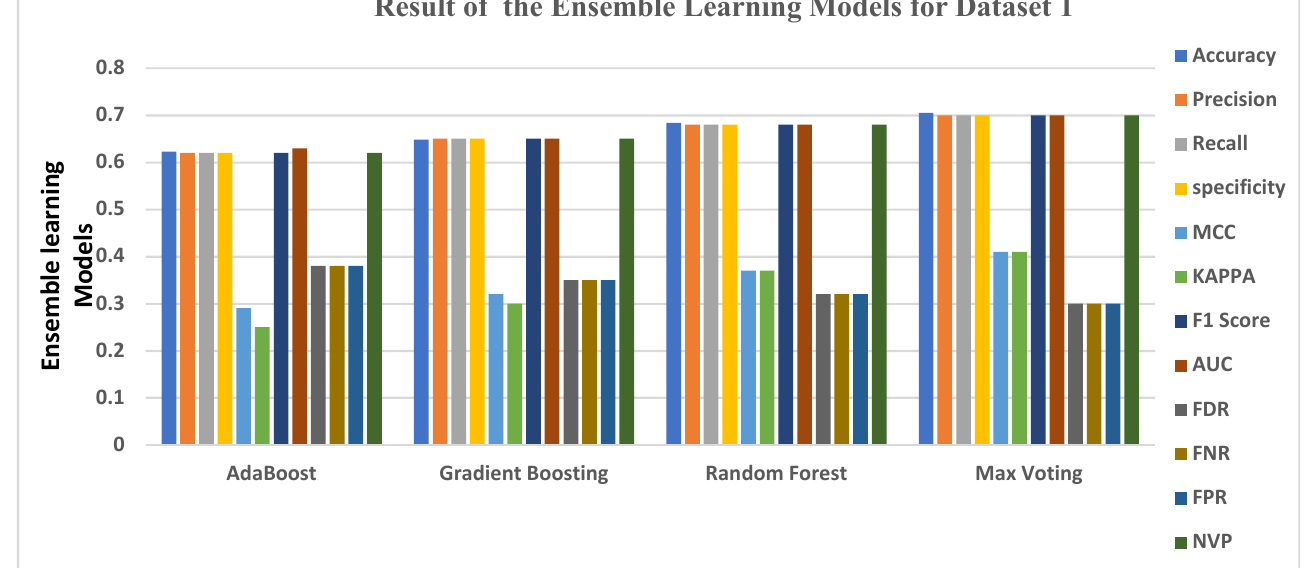
Figure 2. Graphical representation of Evaluation Metrics against Ensemble Learning Models for Dataset 1.